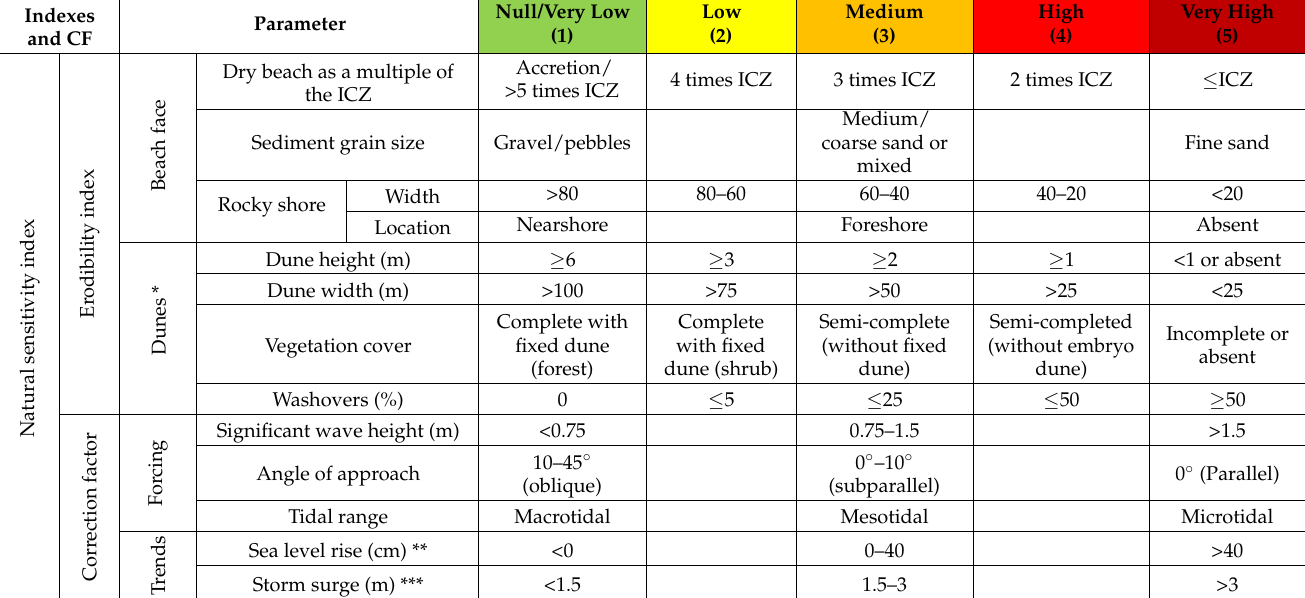
Table 2. Parameters and correction factors used to assess natural sensitivity index (CSSI method).